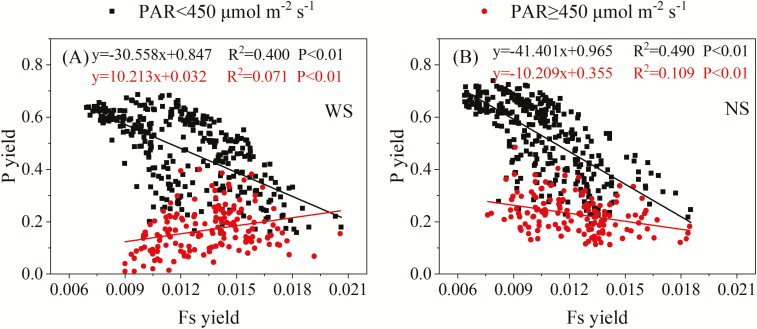
Relationships between Fs yield and P yield at PAR levels lower or higher than 450 μmol m–2 s–1 for the (A) water stress and (B) non-water stress treatments. The fit line and the corresponding equation are shown in the same colour.